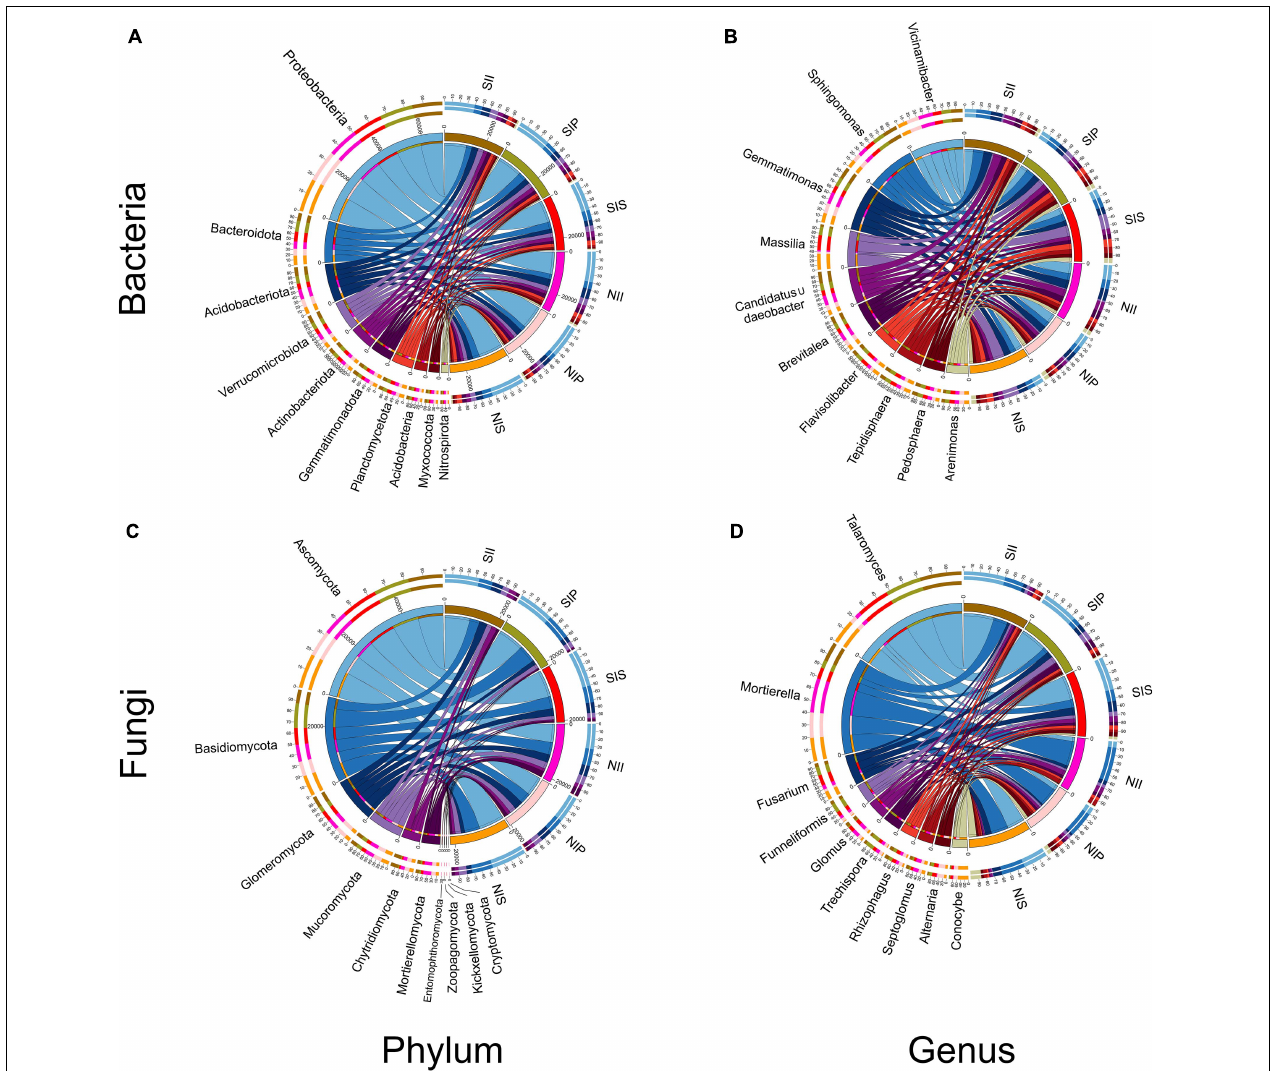
FIGURE 4 | Relative abundance of the peanut rhizosphere (IP), sorghum rhizosphere (IS), and interspecific interaction zone (II) microbial communities at the phylum and genus levels under different soil conditions (S, 0.25% salt-treated soil condition; N, normal soil condition). (A) Bacterial community composition at the phylum level. (B) Bacterial community composition at the genus level. (C) Fungal community composition at the phylum level. (D) Fungal community composition at the genus